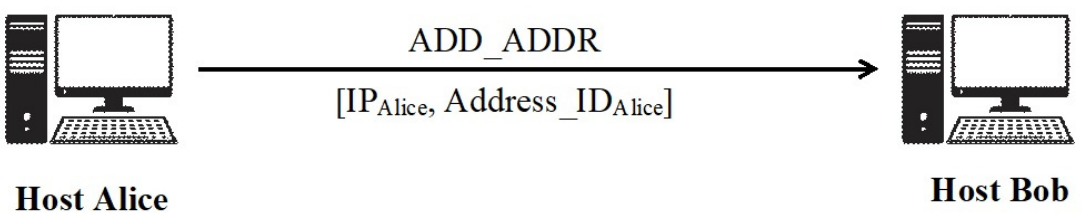
Figure 5. MPTCP Options in Version (v0) advertising new addresses with ADDR.